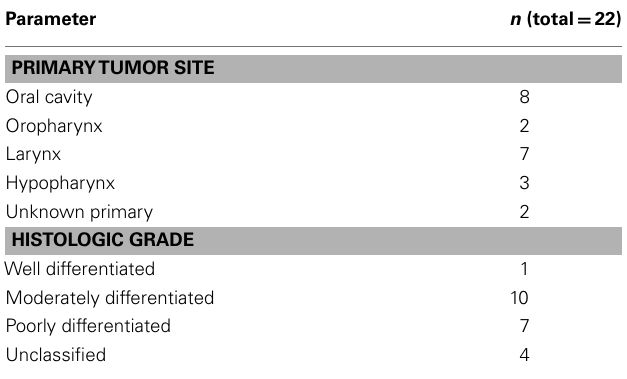
Table 3 | Summary of tumor subsite and histologic grade.